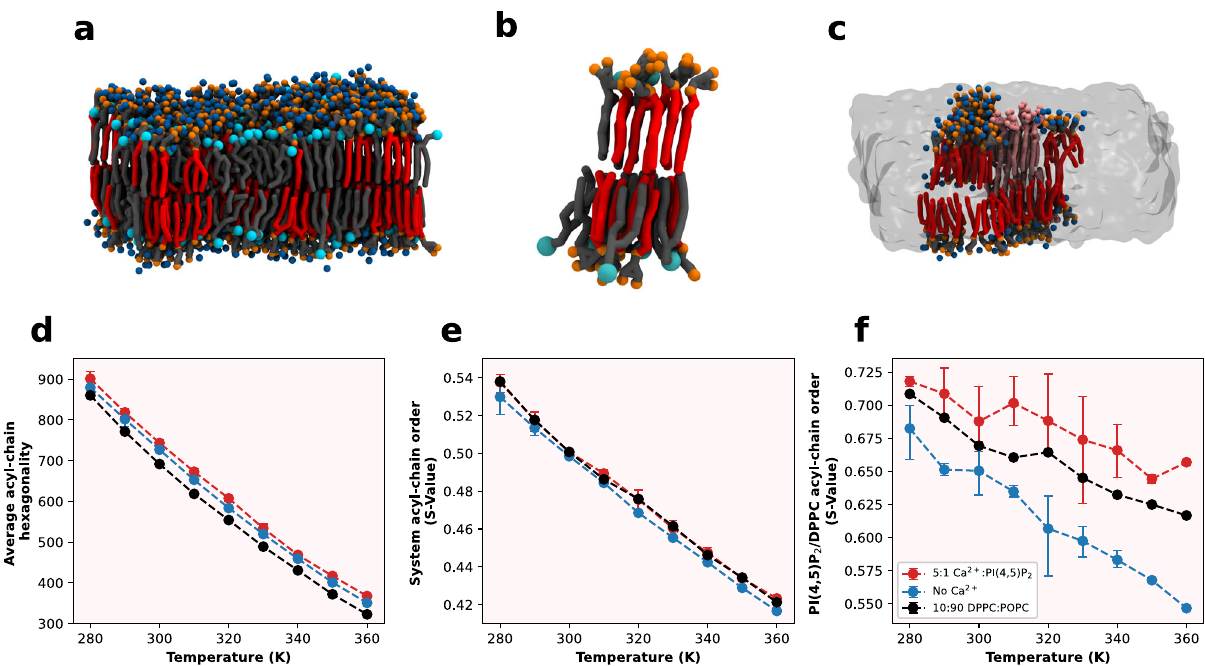
Fig. 7 CG MD study of (16:0) 2 PI(4,5)P 2 gel-phase nanodomains. a Final snapshot of a gel-forming simulation containing 50% mol PI(4,5)P 2 at 280 K. PI(4,5)P 2 gel crystals ( b ) were obtained from this simulation and used for the crystal scaffold simulations ( c ), which were used to characterize gel-phase properties. d Average system-wide acyl-chain hexagonality dependency with temperature for each of the gel-phase crystal scaffold systems studied. e Average system-wide S-value order parameter, calculated on the fi rst acyl-chain bead of every lipid acyl chain, for each of the gel-phase crystal scaffold systems studied. f S-value order parameter for the fi rst acyl-chain bead of every gel-forming lipid acyl chain for each of the systems studied. Error bars for all measurements represent the SD from N = 3 independent simulation